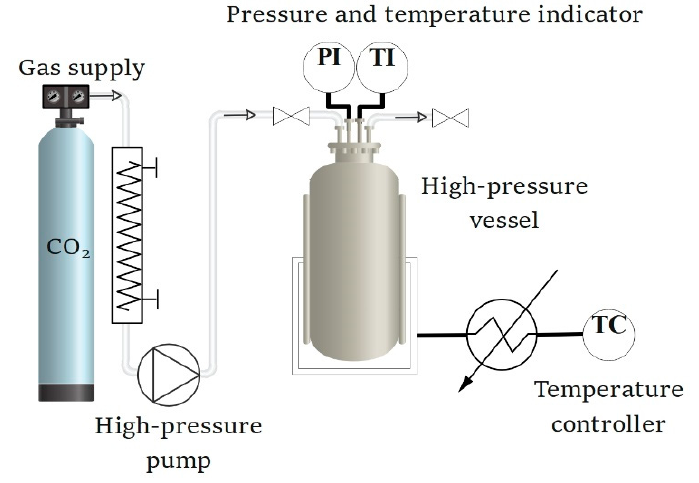
Figure 1. Schematic illustration of the experimental scCO 2 high-pressure reactor.